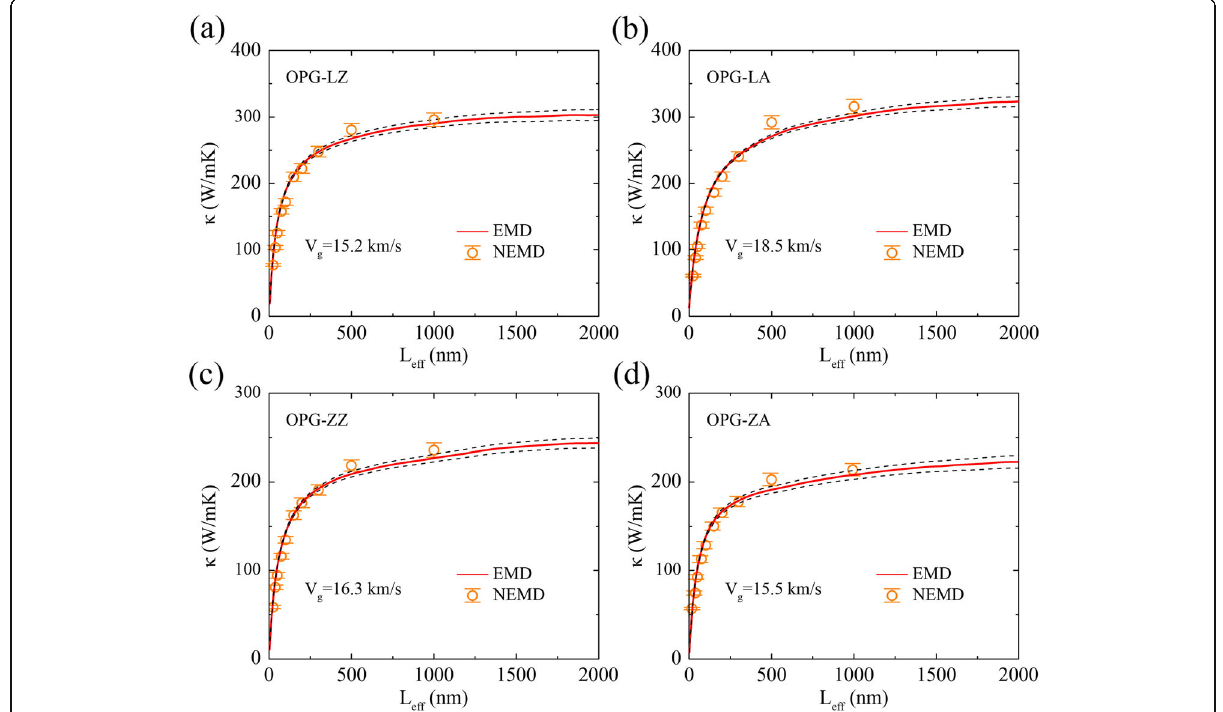
Fig. 7 TC of a OPG-LZ, b OPG-LA, c OPG-ZZ, and ( d ) OPG-ZA as a function of effective sample length from EMD and rNEMD simulations. The effective phonon group velocity V g is obtained by combining EMD and rNEMD